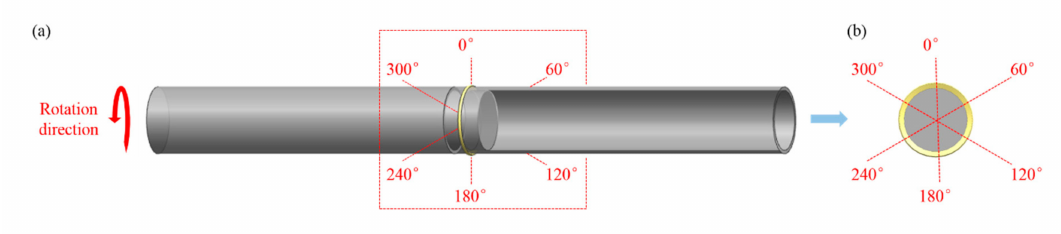
Figure 4. Schematic of the six regions of the laser-welded NS Mo alloy joint in the: ( a ) overall perspective; ( b ) the cross-section perpendicular to the axis of the tube.